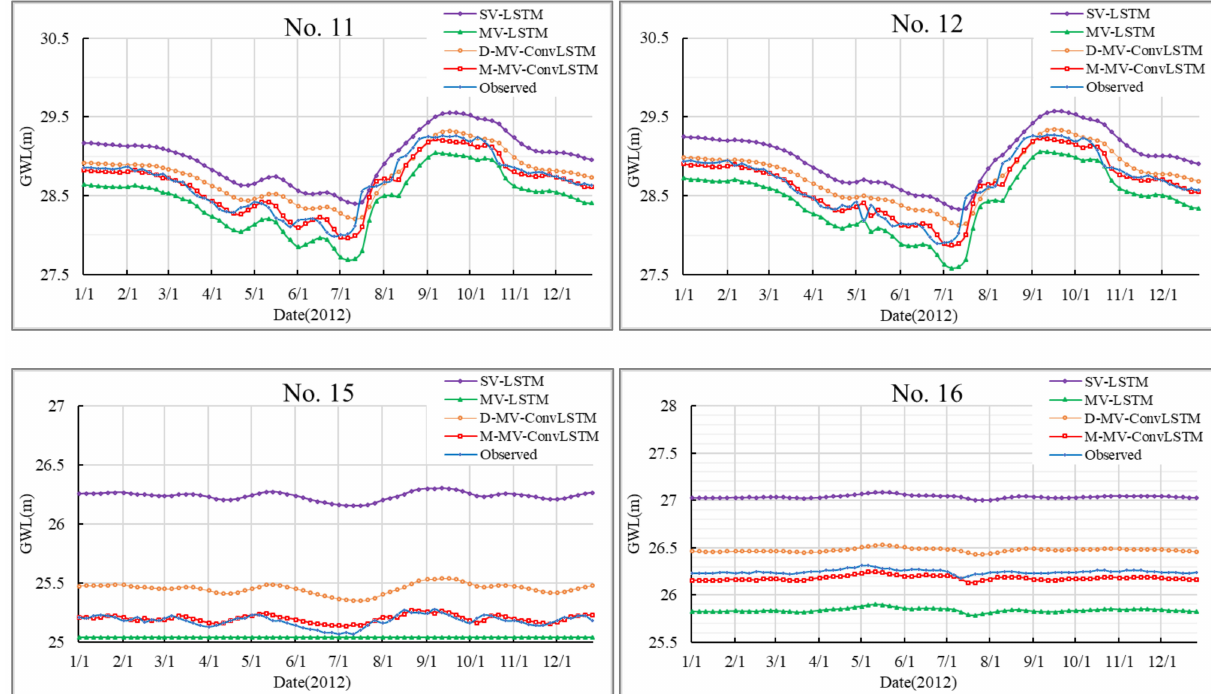
Figure 9. Prediction results of four observation wells (No. 11, No. 12, No. 15, and No. 16) obtained in the four